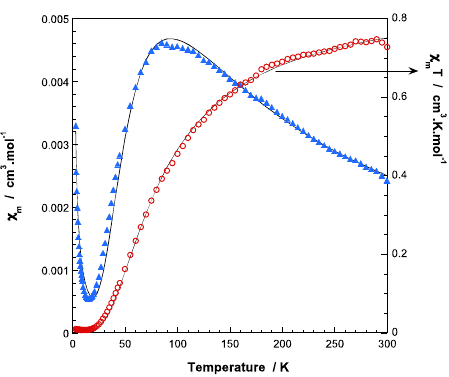
Figure 6. Thermal evolution of χ m (blue triangles) and χ m T product (red circles) for 1.ah . The solid line corresponds to the best theoretical fit (see text for the details).